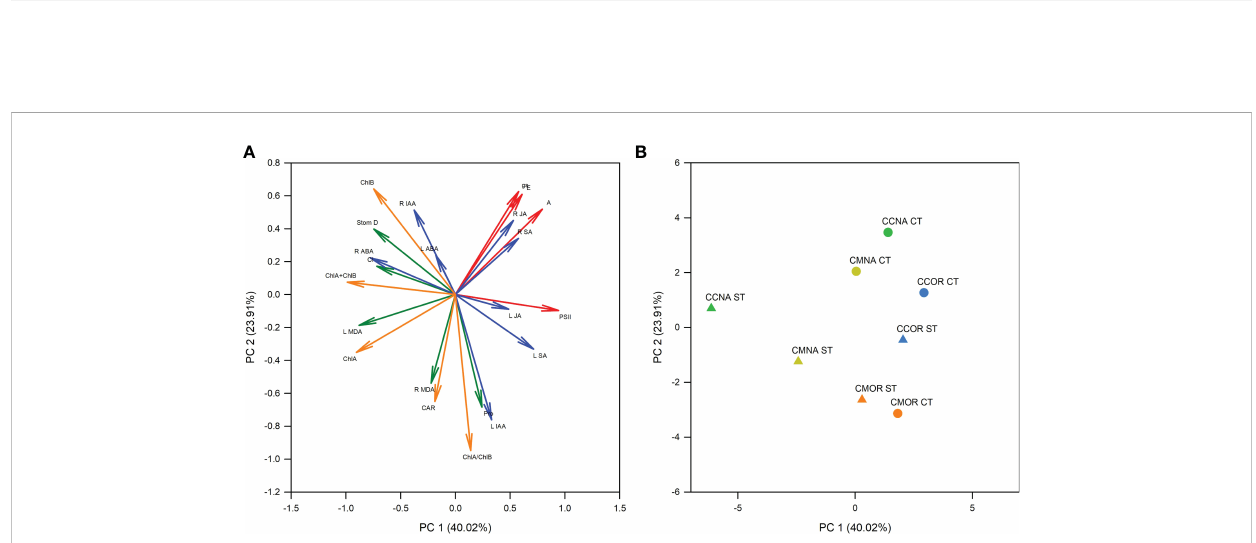
FIGURE 7 Principal component analysis. PCA with the physiological and biochemical data presented in this work. (A) Loading plot, representing photosynthesis related parameters (red arrows), phytohormone content (blue arrows), chlorophyll and carotenoid content (orange arrows), and other biochemical and physiological parameters (green arrows). (B) Scores plot, including the different groups of rootstock/scion combinations, CC-NA (green symbols), CC-OR (blue symbols), CM-NA (yellow symbols), and CM-OR (orange symbols) under control (circles) and salt stress (triangles) conditions.